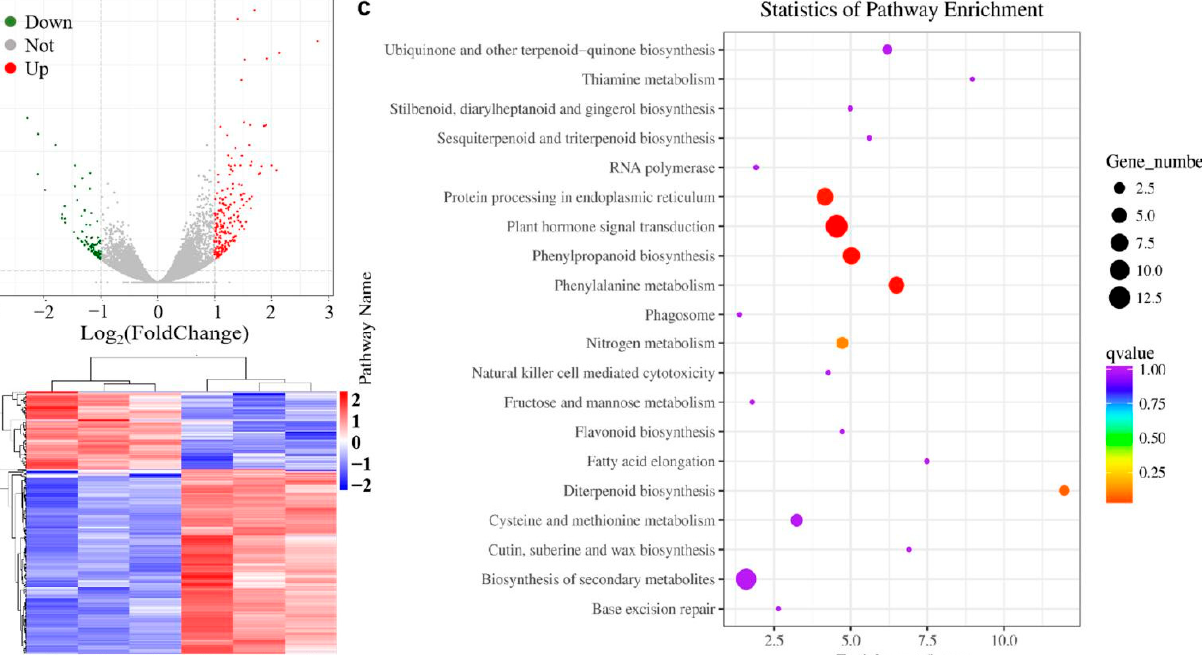
Figure 5. Mineral contents in flat and healthy cucumber stems: ( a ) boron; ( b ) copper; ( c ) manganese; ( d ) iron; (e) zinc; ( f ) magnesium; ( g ) calcium; ( h ) potassium; ( i ) sodium; and ( j ) phosphorus. Differ- ent letters represent significant differences between flat and healthy stems using Duncan’s test ( p < 0.05).